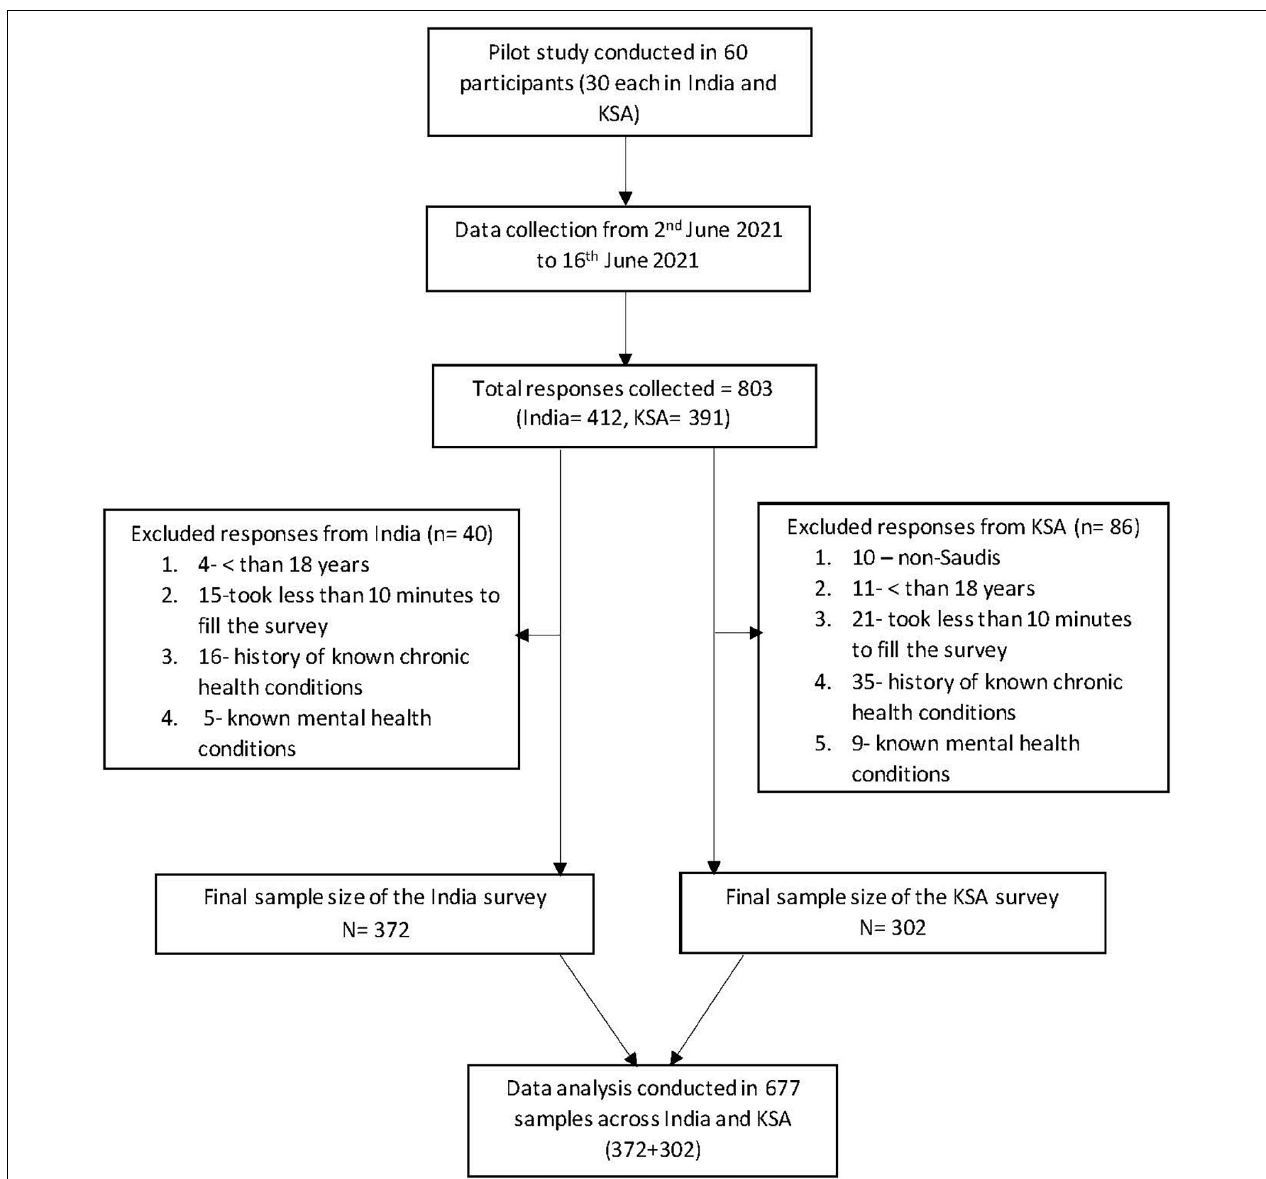
FIGURE 1 | Flow chart illustrating the sample selection in India and KSA. KSA, Kingdom of Saudi Arabia.